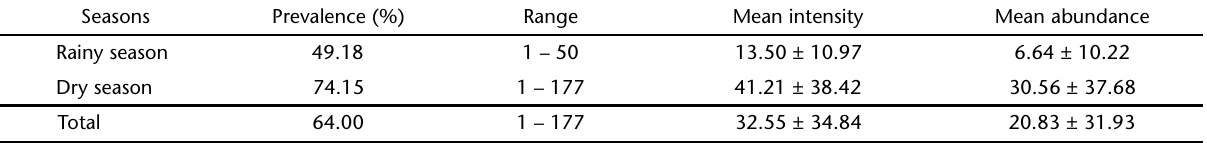
Table I. Prevalence, range, mean intensity, mean abundance of S. nanii of P. argenteus , from the São Francisco River, Três Marias, Minas Gerais, Brazil.